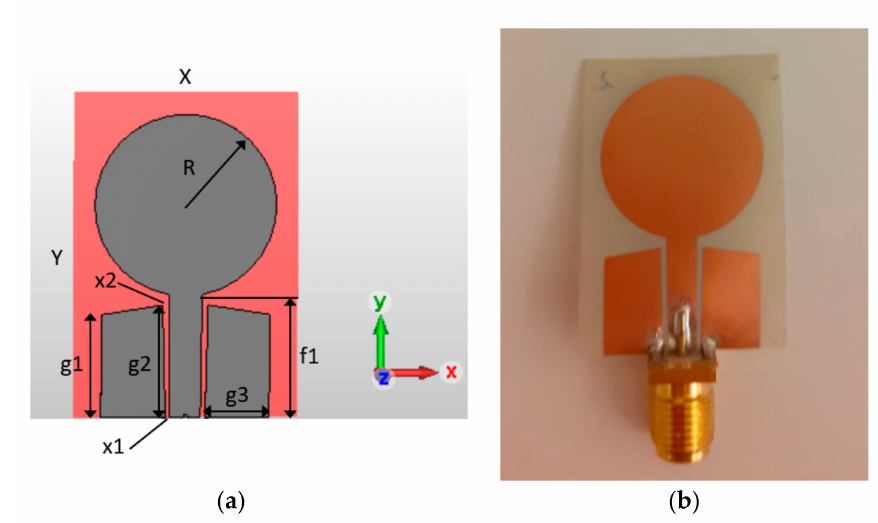
Figure 1. Flexible antenna ( a ) simulation model, ( b ) prototype.